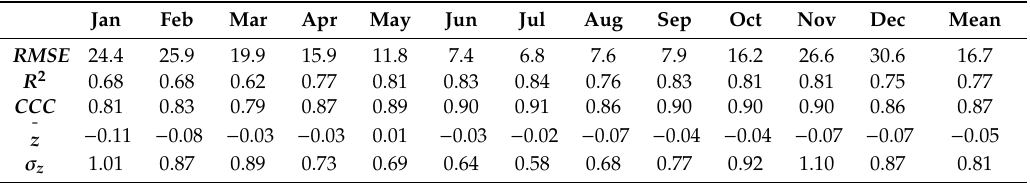
Table 5. Cross validation metrics for monthly precipitation spQRF models. RMSE units are in mm, R 2 , z-score related values and Concordance Correlation Coefficient ( CCC ) are unitless.